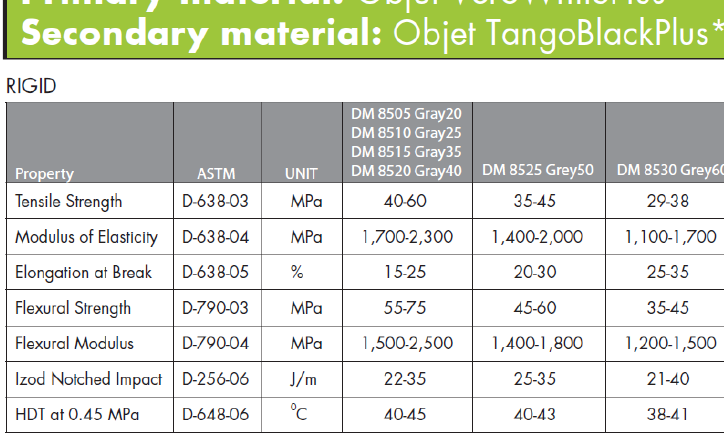
Figure A8. DM8510, DM8520, and DM8530 material sheet from Stratasys. (Source: http://www.stratasys.com.cn/industries/education/research/4d%20printing%20project. Measurement of shape recovery of single material specimens (raw data))